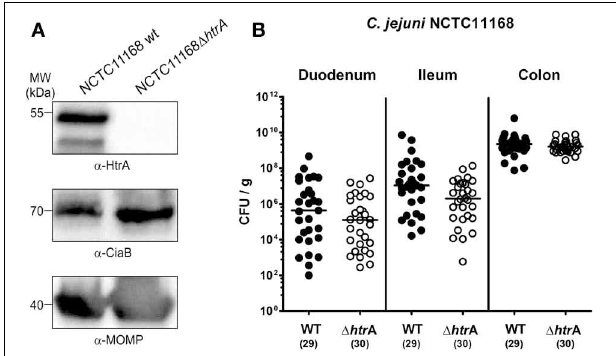
FIGURE 1 | C. jejuni colonization along the intestinal tract of gnotobiotic IL-10 − / − mice is independent of htrA gene expression. (A) Control Western blots for the expression of indicated proteins in the two C. jejuni strains used in this infection study. (B) Gnotobiotic IL-10 − / − mice were generated by broad-spectrum antibiotic treatment and perorally infected with C. jejuni NCTC11168 wild-type strain (WT, closed circles) or mutant strain NCTC11168 (cid:2) htrA ( (cid:2) htrA , open circles). The pathogen densities in distinct compartments of the intestinal tract were determined by quantification of live C. jejuni in luminal samples taken from duodenum, ileum, and colon at day 6 p.i. by cultural analysis (CFU, colony forming units). Medians (black bars) are indicated and numbers of analyzed animals given in parentheses. Data shown were combined from five independent experiments.